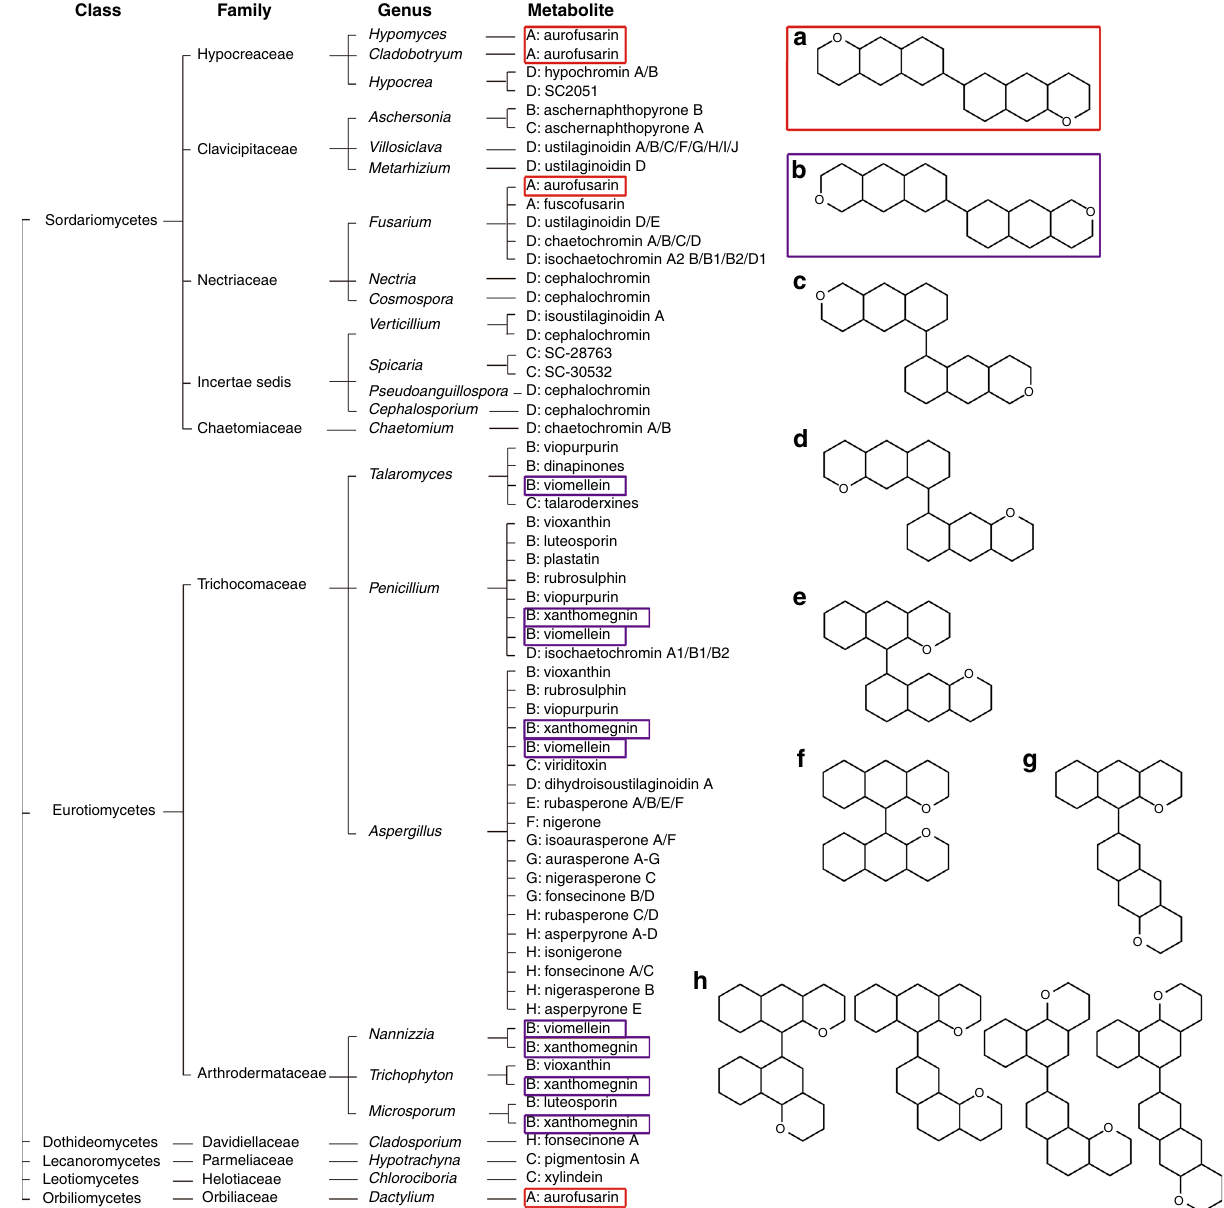
Fig. 7 Production of dimeric naphthopyrones by ascomycetous fungi. The taxonomic af fi liation of selected fungal genera that produce dimeric naphthopyrones 27 is shown on the left with schematic structures of bis-naphthopyrones on the right. The Structure Classes A to G contain dimeric naphtho- α -pyrones and naphtho- γ -pyrones consisting of linear heptaketides; the classes differ by the position of the link between monomers and by the presence of either α - or γ -pyrones. The metabolites of Class H contain angular heptaketides, and all metabolites of this class listed here contain γ -pyrones. The metabolites used in this study have been